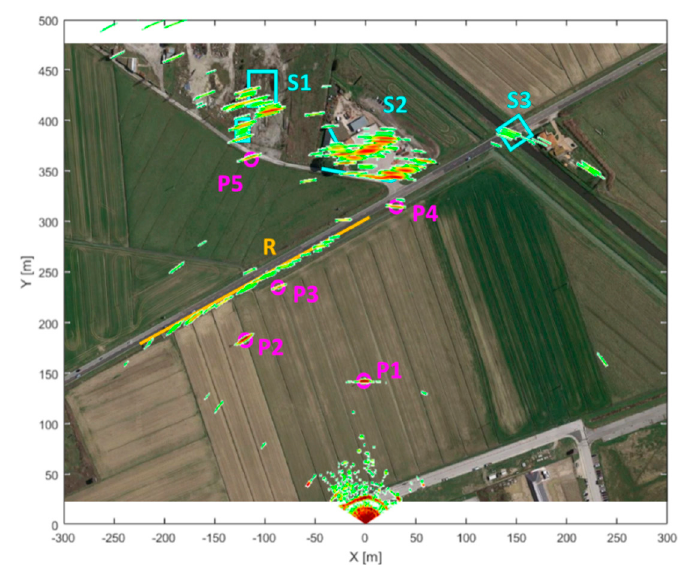
Figure 13. SPARX SNR estimated map superimposed on the acquisition scenario top view.